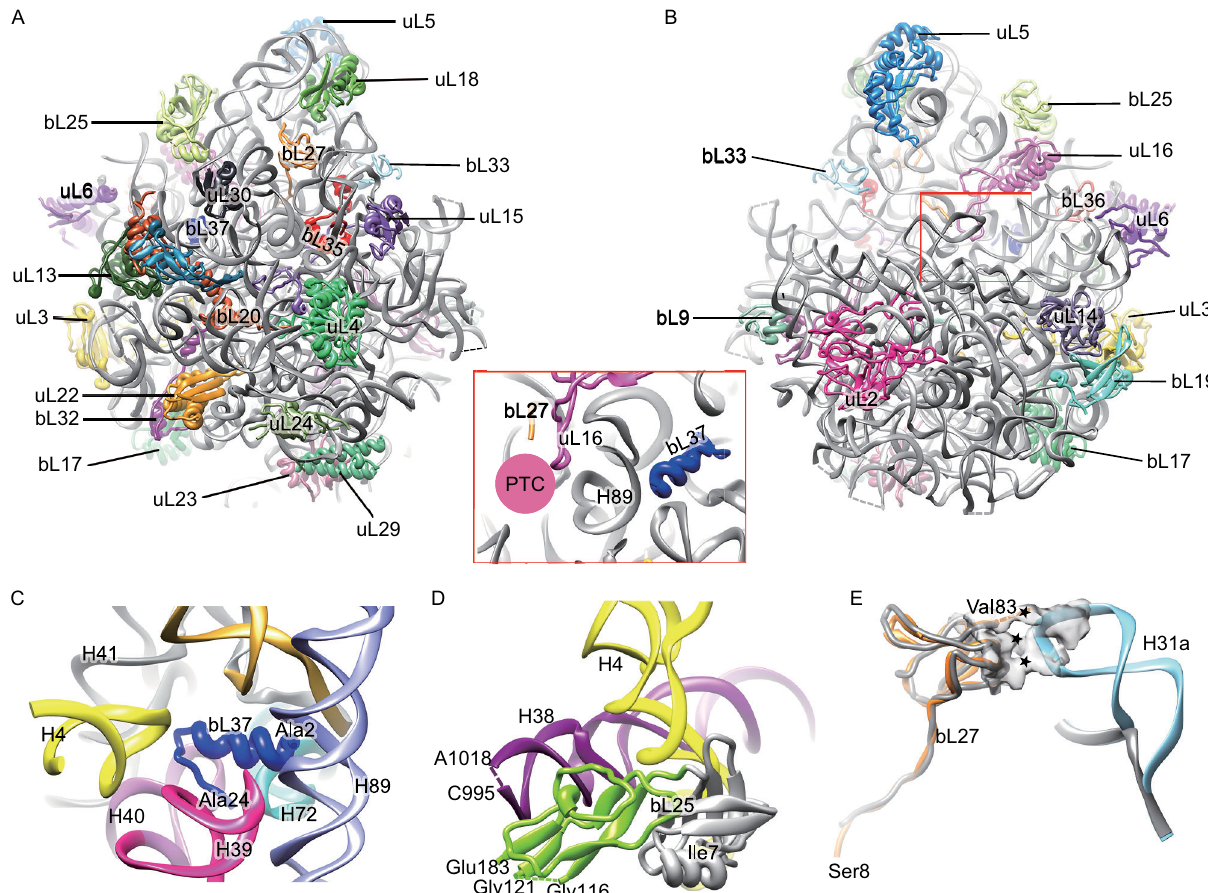
Figure 2. Overall atomic model and unique features in the MS 50S . (A and B) Atomic model of the MS 50S, viewed from solvent surface (A) and inter-subunit surface (B). Inset, relative orientation of bL27 with respect to the peptidyl transferase center (PTC). (C) Ribosomal protein bL37 is encircled by H4, H39, H40, base of H41 and H42, H72 and H89. (D) The extra C-terminal domain of bL25 is in proximity to H38 (purple). Conserved N-terminal domain of bL25 is colored gray while the extra C-terminal domain is colored green. (E) The extended H31 interacts with bL27, N-terminus of which extends to the peptidyl transfer center. The interaction sites are indicated by asterisks. Protein bL27 and H31a in the MS 70S are colored with orange and cyan, respectively, while their counterparts in the EC 70S are in gray. The coordinates of the E . coli components are from a crystallography study (PDB 4KIX) (Pulk and Cate,